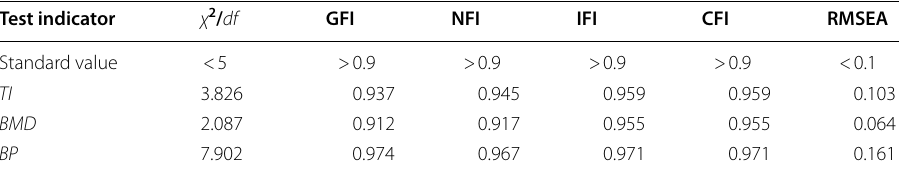
Table 4 Fitting index statistics of the measurement model Test